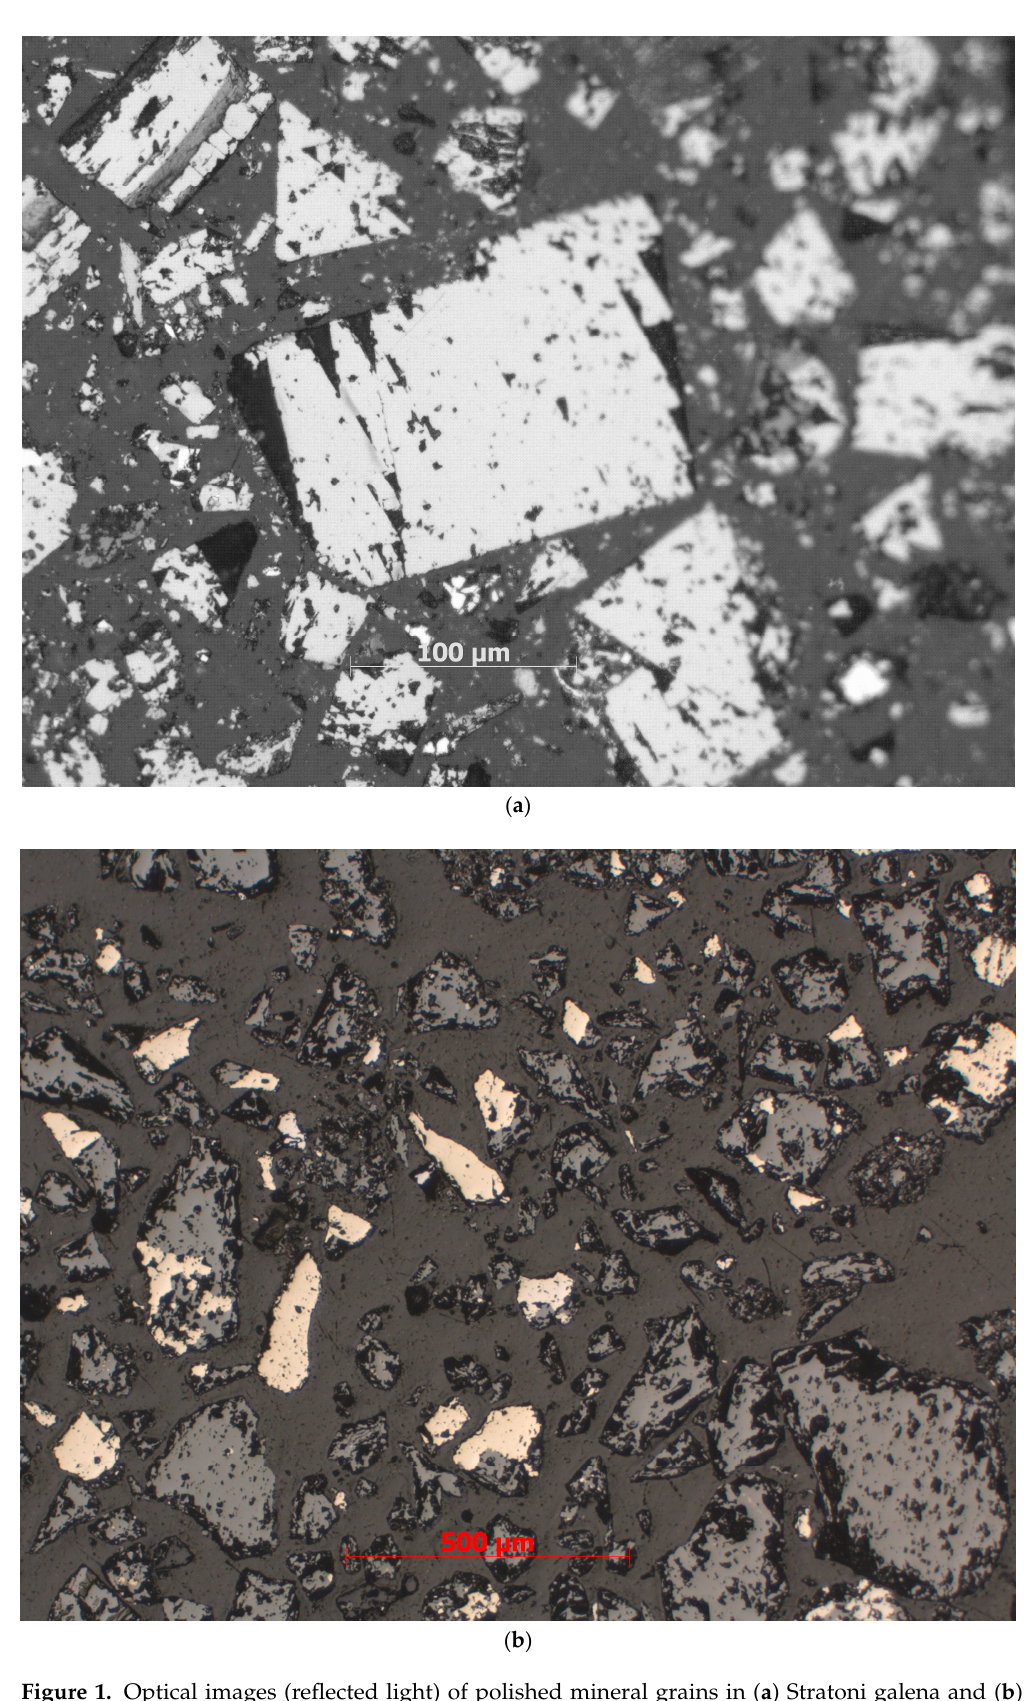
Figure 1. Optical images (reflected light) of polished mineral grains in ( a ) Stratoni galena and ( b ) sphalerite concentrates.